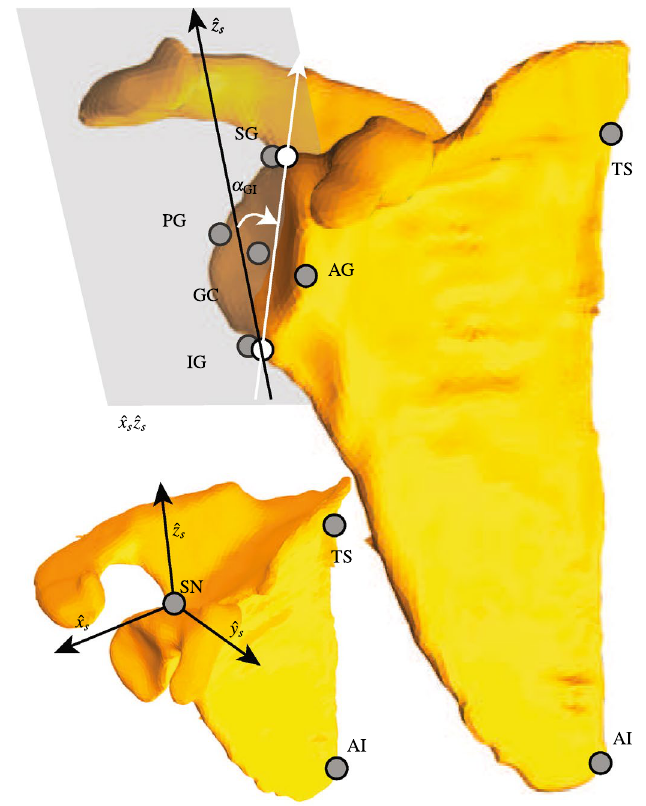
is attached to SN and is defined according to Eq. (15). The α GI is defined in ˆ x s ˆ z s plane where the two points IG and SG are projected (white circles). It is defined as the angle between the ˆ z s and a vector passes through the two constraint (Eq.